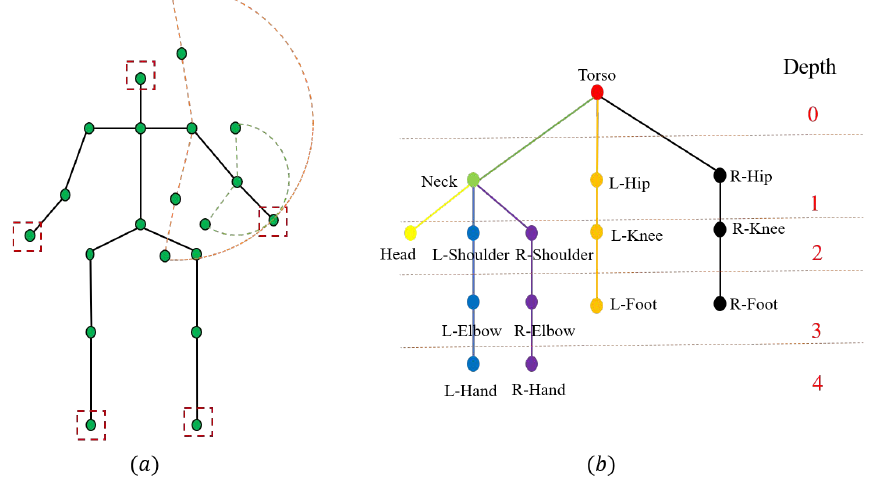
Figure 1. ( a ) The structure of the human skeleton model. The distal joints are denoted in the red dotted box. The active range of the right hand is denoted by the orange dotted line when the position of the right elbow is unknown. The active range of the left hand is denoted by the green dotted line when the position of the right elbow is known. ( b ) The structure of the human-tree model. The depth of the joint is denoted on the right